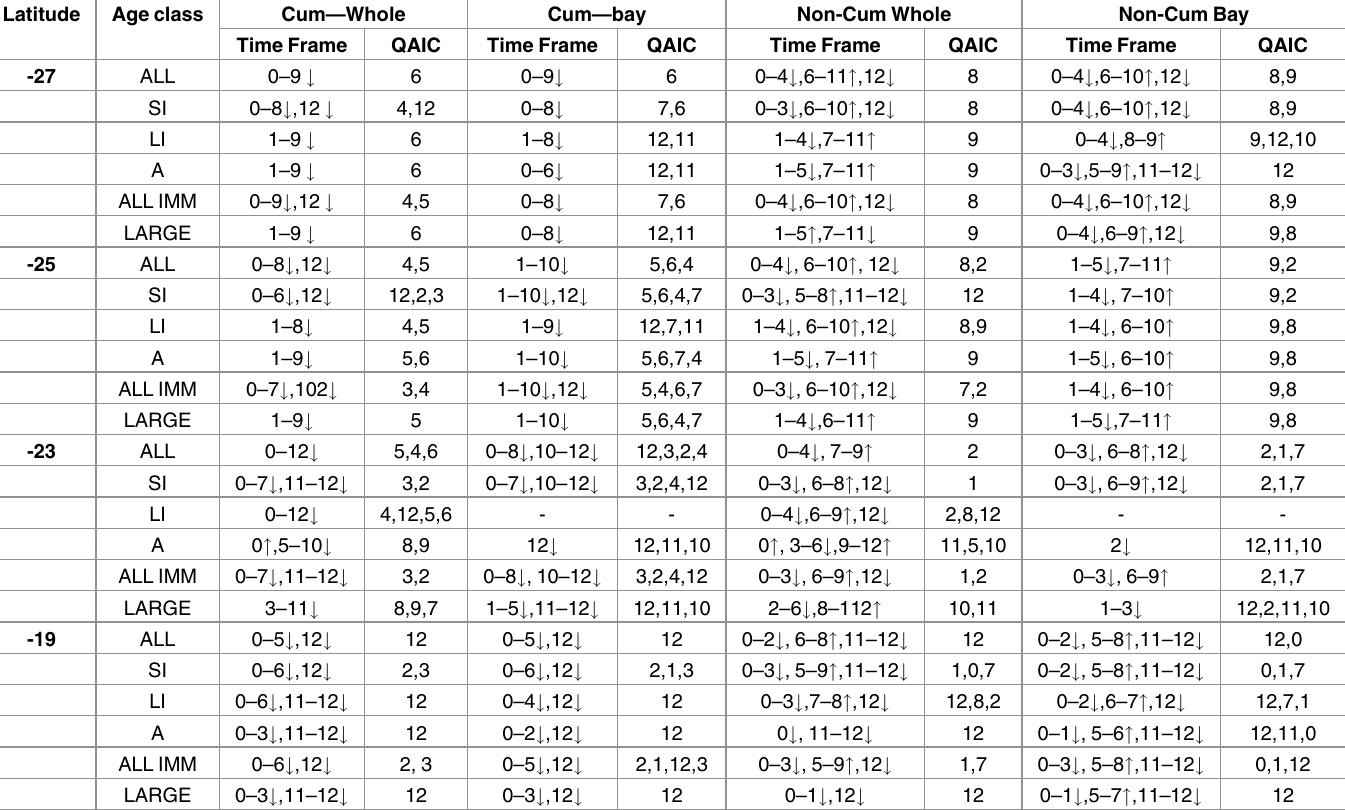
Table 7. Model results for green turtles and monthly mean minimum air temperature. " denotesincreasedstrandings rates with increasedmean mini- mum air temperature. # denotesdecreased strandingrates with increasedmean minimumair temperature. Age class abbreviations: ALL = all turtles, SI = small immature, LI = large immatures, A = adult-sized, ALL IMM = all immature sized animals(small + large), Large = all large turtles (large immatures + adult-sized).The time frame is reportedin monthly ranges where responses were noted. The values reportedin qAIC are the months with the most signifi- cant qAIC